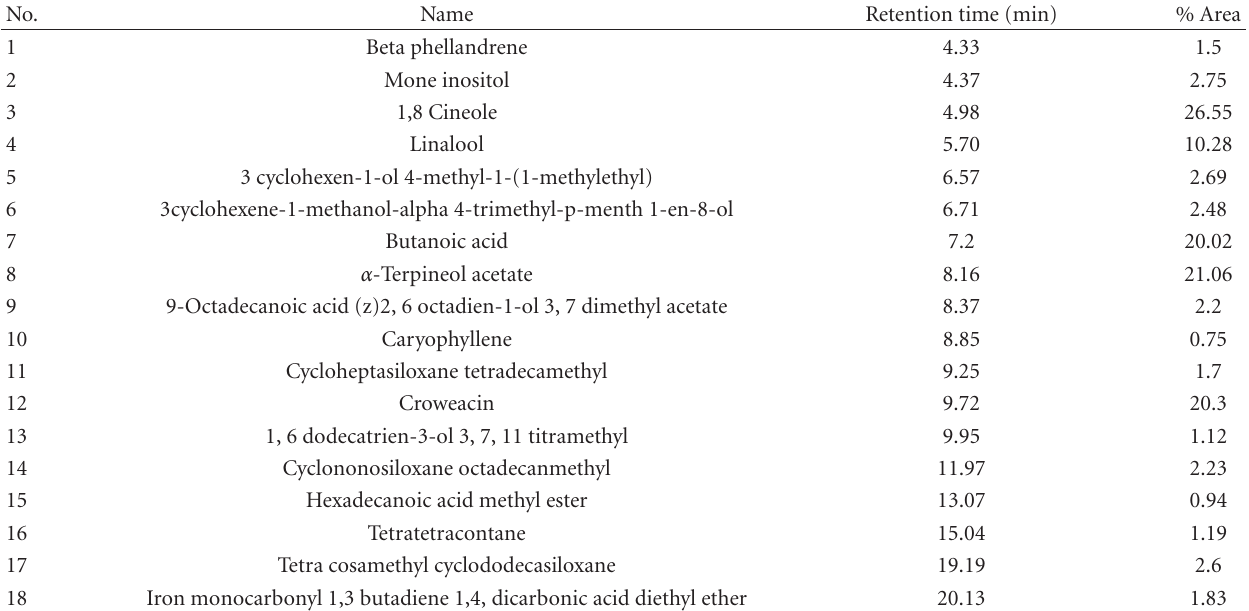
Table 5: The main constituents of C. senna plant extract identified by GC-MS